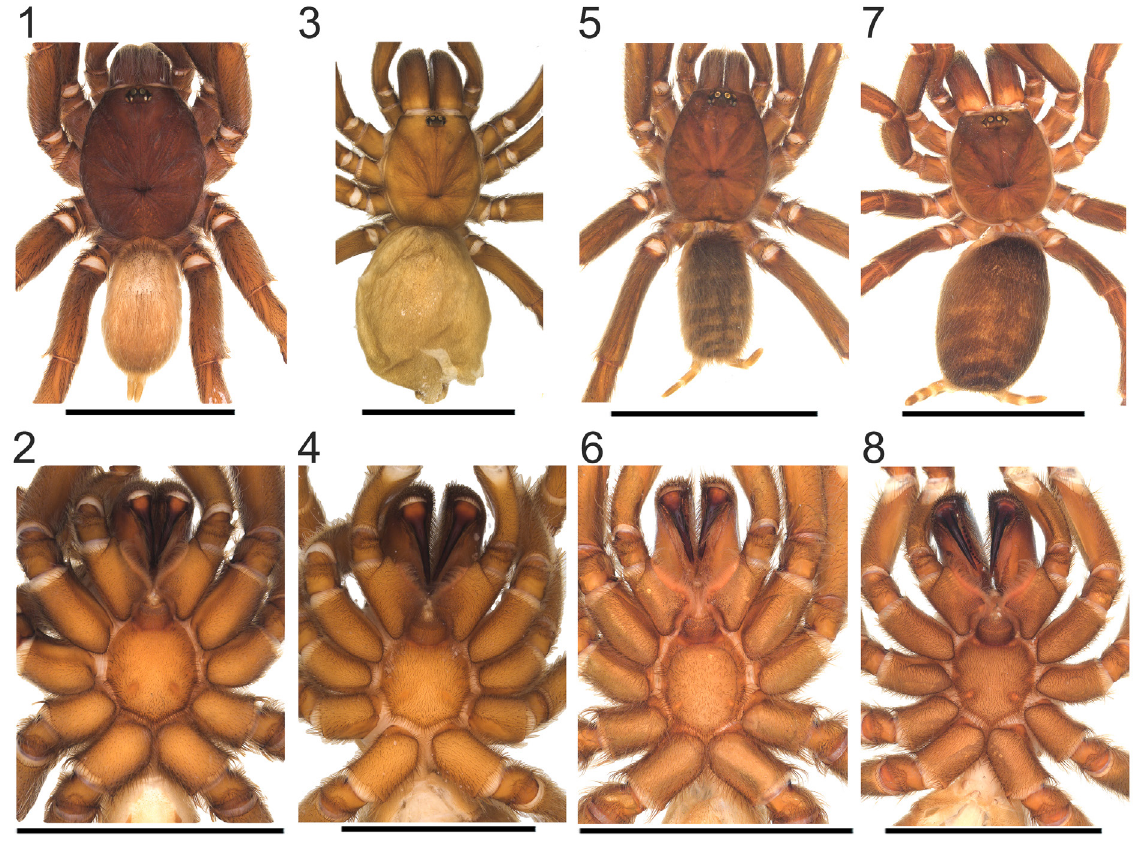
Figs 1–8. Schismatothele spp. 1–4 . Schismatothele caeri sp. nov. 1–2 . Holotype, ♂ (MZSP 47440). 1 . Dorsal view. 2 . Prosoma, ventral view. 3–4 . Paratype, ♀ (MZSP 47427). 3 . Dorsal view. 4 . Prosoma, ventral view. – 5–8 . Schismatothele caiquetia sp. nov. 5–6 . Holotype, ♂ (MZSP 28423). 5 . Dorsal view. 6 . Prosoma, ventral view. 7–8 . Paratype, ♀ (MZSP 28424). 7 . Dorsal view. 8 . Prosoma, ventral view. Scale bars = 10